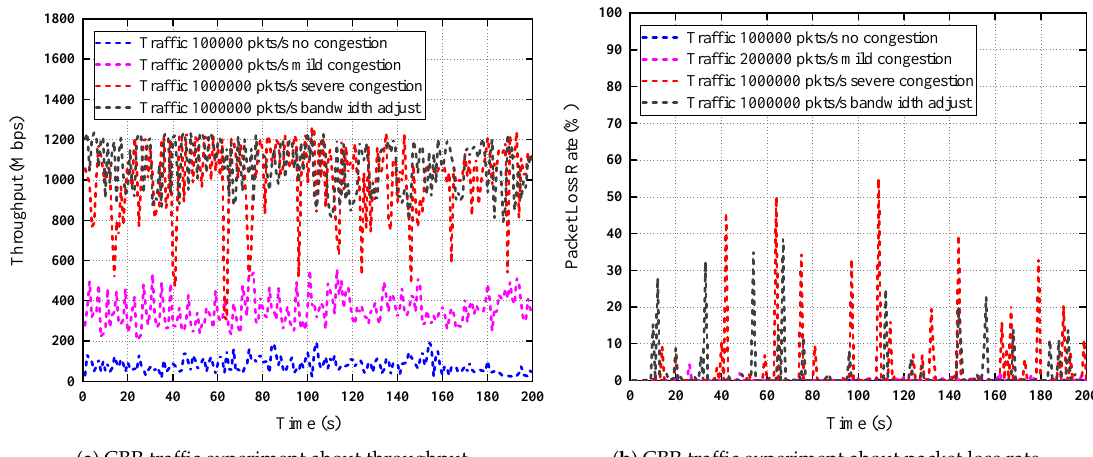
Figure 13. CBR traffic experiments over the Mininet